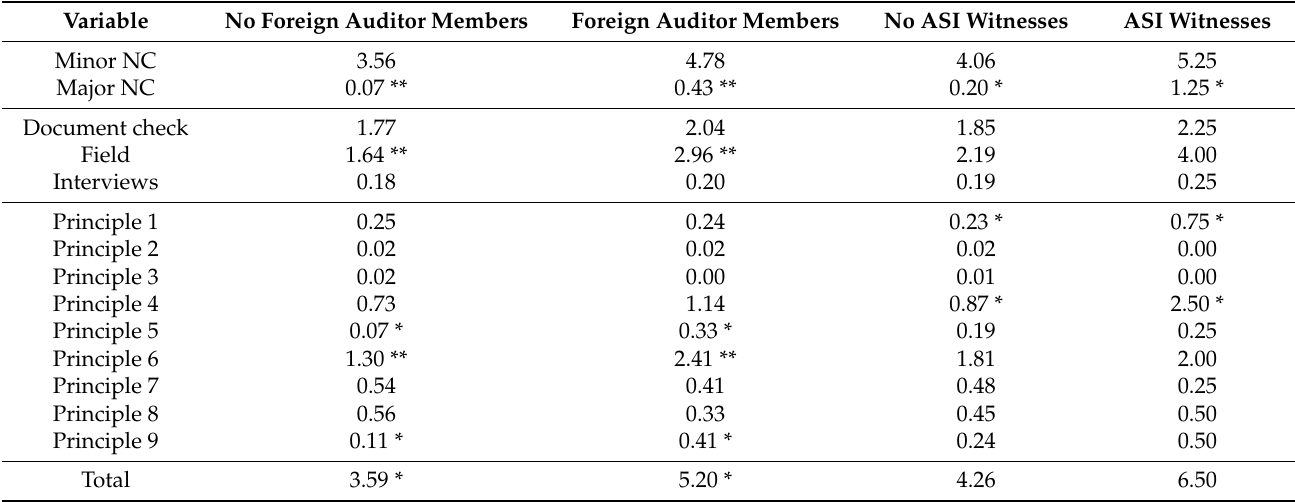
Table 4. Analysis of the NCs identified according to the participation of foreign members and ASI witnesses in the auditing